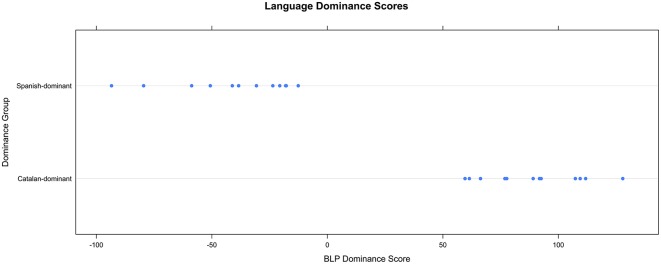
Language dominance as a function of group according to the BLP (Birdsong et al., 2012).